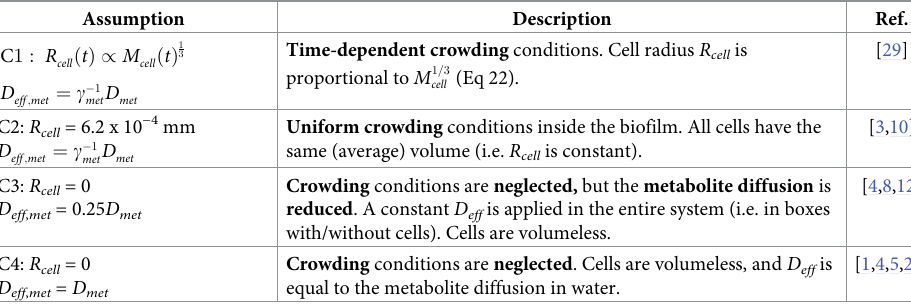
a maximum of one cell is allowed per box, thus Δ x = 2 R = 1.3 x 10 − 3 mm. To avoid max , cell numerical instabilities, Δ t was set to be proportional to the diffusion of the fastest metabolite in the system. In this case, it was O , so Δ t = Δ x 2 /4 D = 0.2 ms. 2 O2 To select the amount of glucose supplied to the system in the simulation, we considered that E . coli is found at the end of the small intestine where the glucose concentration is about 2.25 mM [27]. Here, we assumed that an infinite nutrient reservoir was located at the top boundary, with a constant concentration of 2.25 mM of glucose and 0.21 mM of O (only glu- 2 cose and O can leave/enter the system through the top boundary). The O concentration 2 2 (0.21 mM) at the top boundary was computed using Henry’s law, assuming that the fresh medium supplied was at equilibrium with a gas phase where the partial pressure of O was 2 0.162 atm, and with Henry’s law constant of 1.3 mmol L − 1 atm − 1 [28]. At time t = 0 h, all boxes with available space contained medium with 0.5 mM of glucose and 0.21 mM of O . Since sig- 2 nificant amounts of acetate are secreted under both aerobic and anaerobic conditions and in order to keep the biofilm problem as simple as possible, only the diffusion of glucose, O , and 2 acetate were tracked during the simulation. Because we assumed that cell radius R was pro- cell portional to M 1 = 3 , the crowding conditions changed over time (this crowding assumption is cell identified as C1, see Table 2). The radii of the metabolites glucose, O , and acetate were fixed 2 to zero. All results were averaged over three replicate simulations. Table 2. Crowding assumptions tested in the